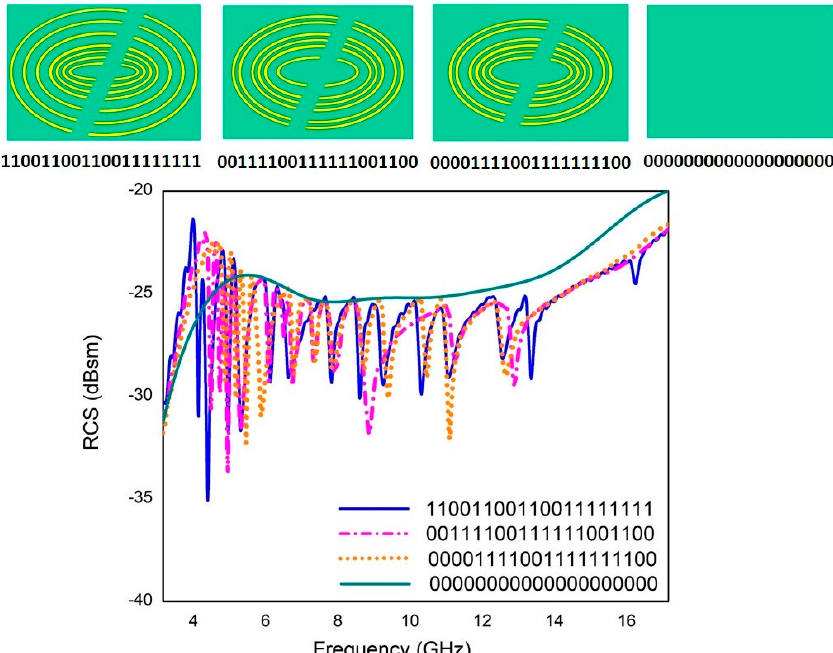
Figure 12. Various bit encoding sequences.